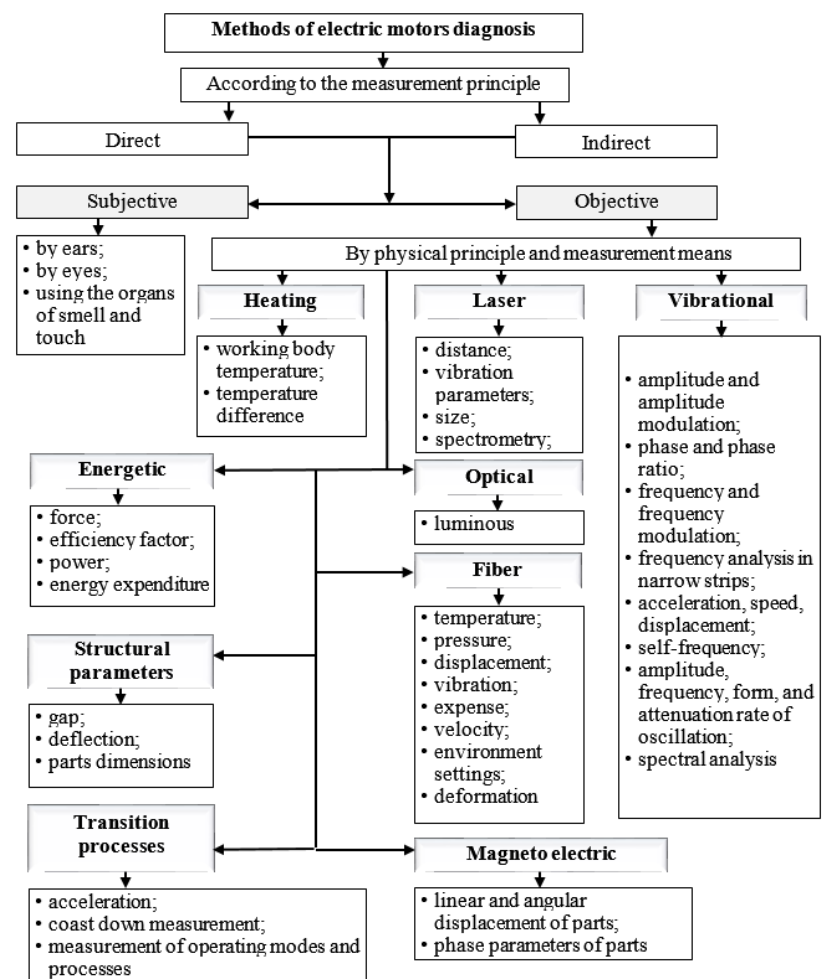
Figure 2. Classification of diagnosis